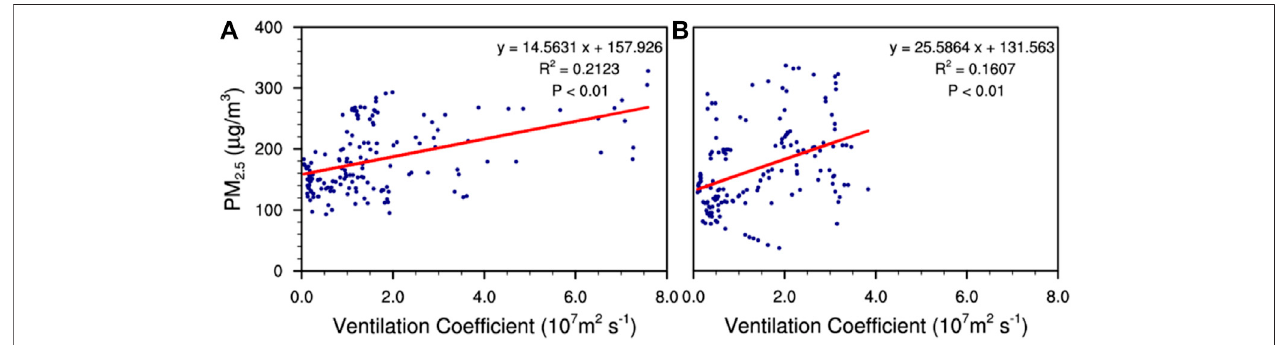
FIGURE 4 | Correlations of the surface PM 2.5 concentration to the ventilation coef fi cient (10 7 m 2 s − 1 ) over the region (112 – 114 ° E and 30.5 – 31 ° N) averaged in the early growth stage of six typical episodes for (A) RTT and (B) SAT in JM, respectively; the early growth stage of all patterns indicates the correlations are signi fi cant at